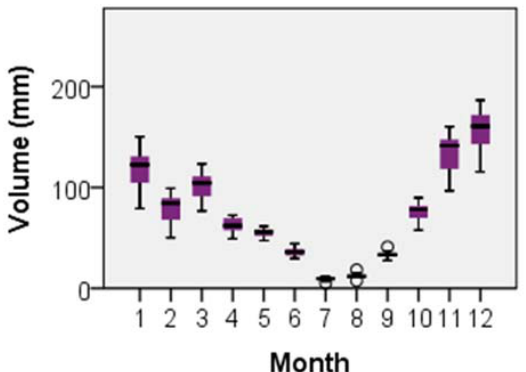
Figure 8. Average monthly volume (mm) over the period of record for all stations. Box shows 50% of the data, with median represented as a black bar. The whisker extends to two standard deviations of the data, and circles represent